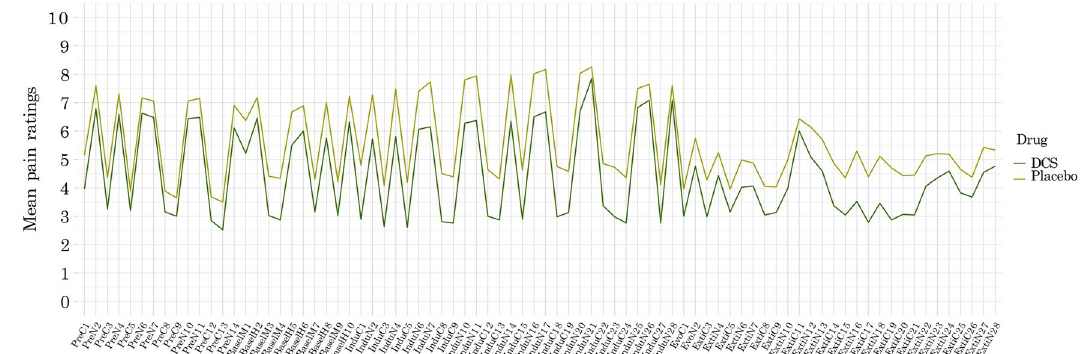
Figure 4. Timeseries of all trials. Mean pain ratings are shown in pre-conditioning ( Pre ) baseline ( Basel ), nocebo induction ( Indu ), and extinction ( Ext ) including the first two extinction trials ( Evocation ) where behavioral nocebo effects were measured. D-cycloserine (DCS) administration did not significantly affect the magnitude of nocebo responses. The slight group difference in ratings observed indicates a minor average difference in individually calibrated pain intensities that was already present prior to DCS administration and had no significant effects on outcomes (all p >